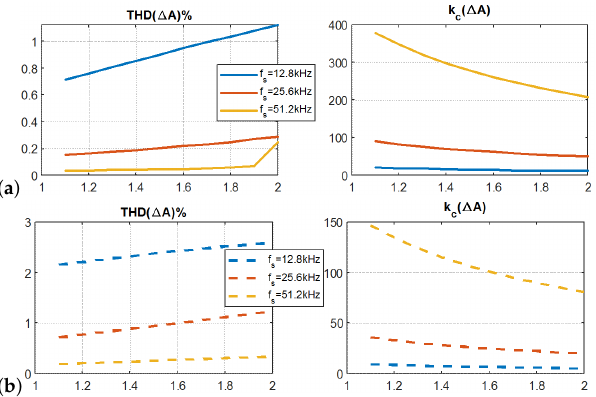
Figure 14. Dependence of THD and the gain k c from the gain margin ∆ A for different values carrier frequency f s : ( a ) 1Lh PID and ( b ) 1Ld